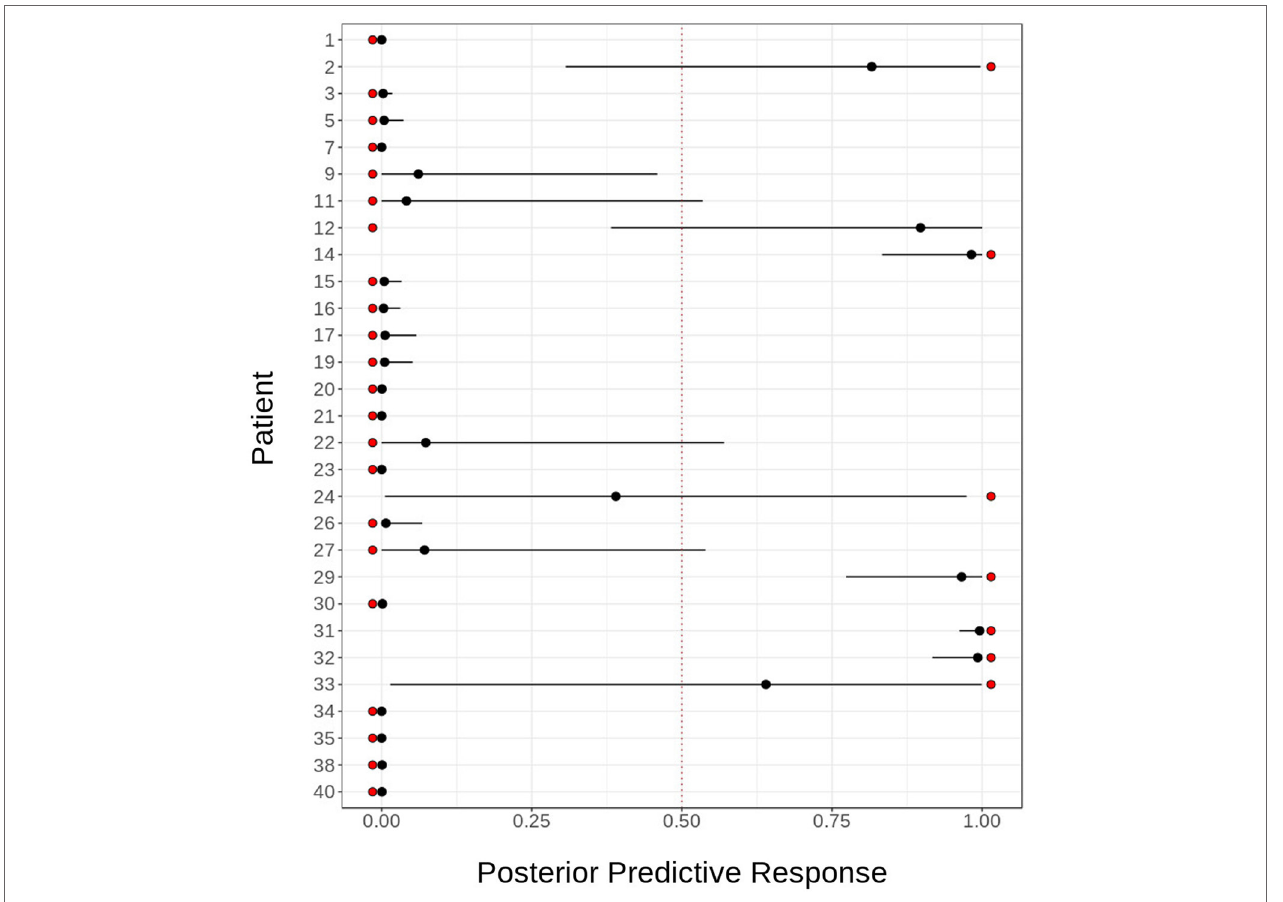
FigUre 8 | Sensitivity and specificity of predictive model. Predictive model validation: in order to assess the goodness of our predictive model for fingolimod response, we validated it using cytometry and transcriptomic data for 29 patients. The figure shows the actual response (red dots) against the posterior distribution of the predicted response, represented by its mean (black dot) and 95% quantile (black line). The model fails to predict the response for two patients: 1,315 and